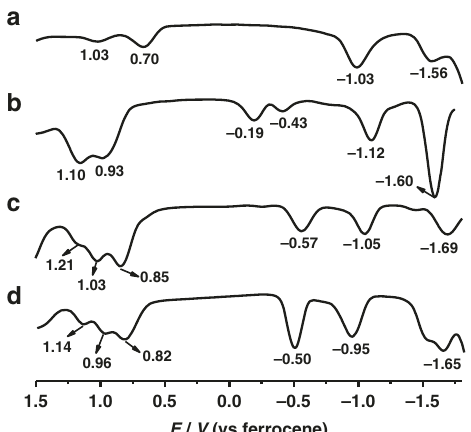
Fig. 5 Electrochemical studies of the dimers considered in this study and the monomer FHP. Differential pulse voltammograms (DPV) of FHP ( a ), D ( b ), MD1 ( c ), and MD2 ( d ). DPV measurements were conducted in anhydrous CH 2 Cl 2 containing 0.1 M tetra- n -butylammonium perchlorate (TBAClO 4 ) as the supporting electrolyte. A three-electrode cell was used: a glassy carbon (working electrode), platinum wire (counter electrode), and Ag/AgCl (reference electrode). Ferrocene/ferrocenium (Fc/Fc − ) was used as an external